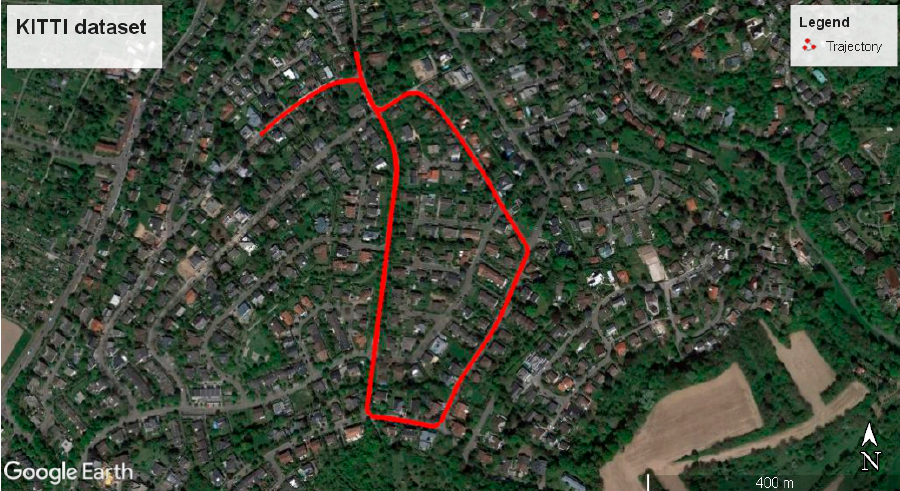
Figure 5. The trajectory of the KITTI dataset, #34. It is the longest KITTI dataset where the vehicle travels more than 1.7 km.